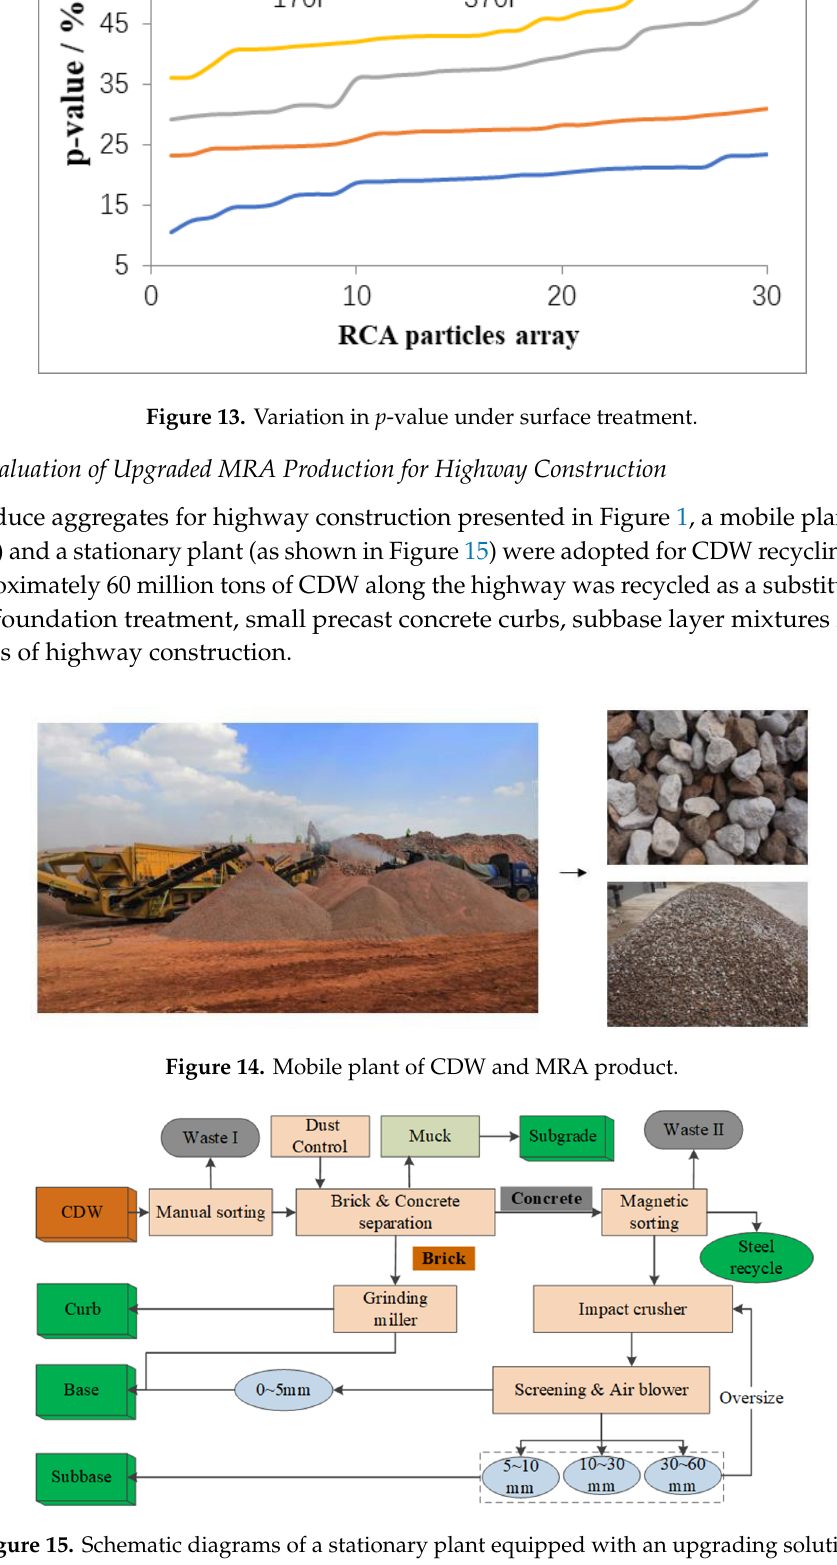
Figure 15. Schematic diagrams of a stationary plant equipped with an upgrading solution.